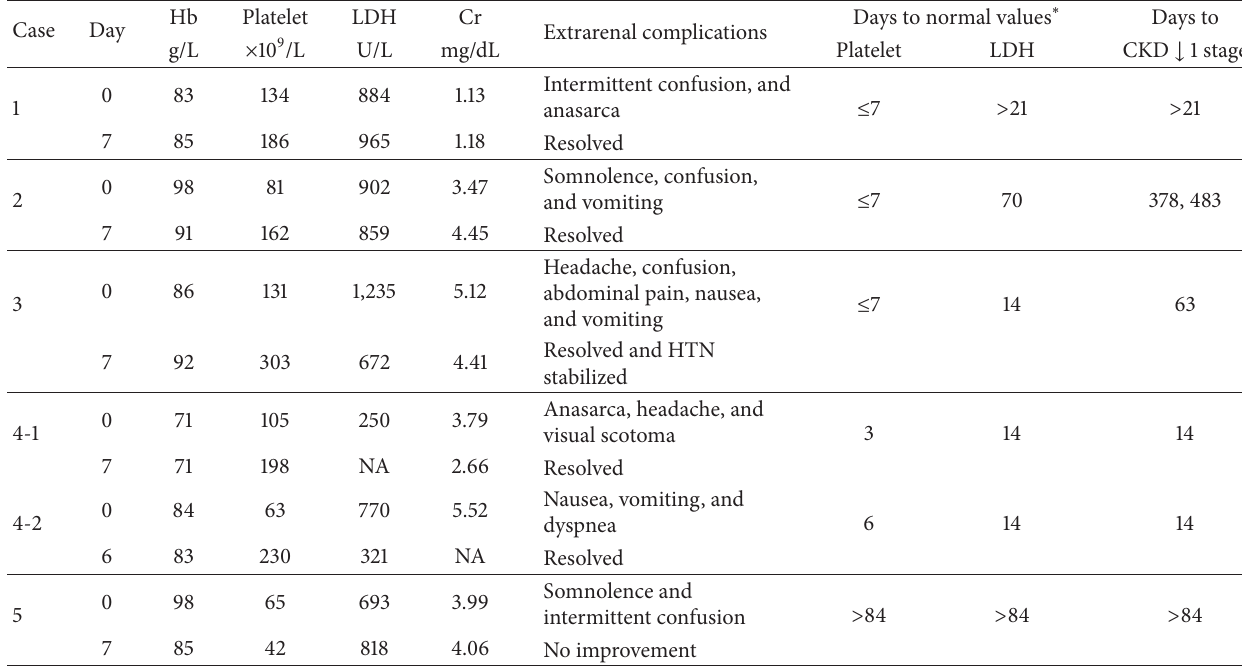
Table 3: Responses to eculizumab